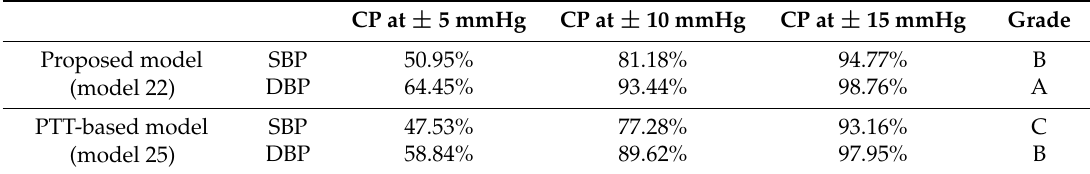
Table 4. Accuracy evaluation based on the British Hypertension Society (BHS)